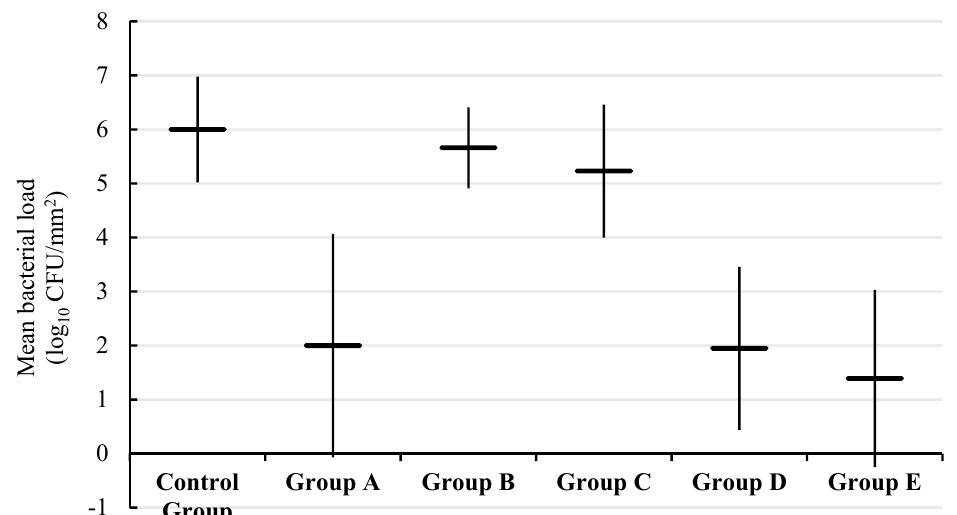
/ mm 2 ) in each experimental